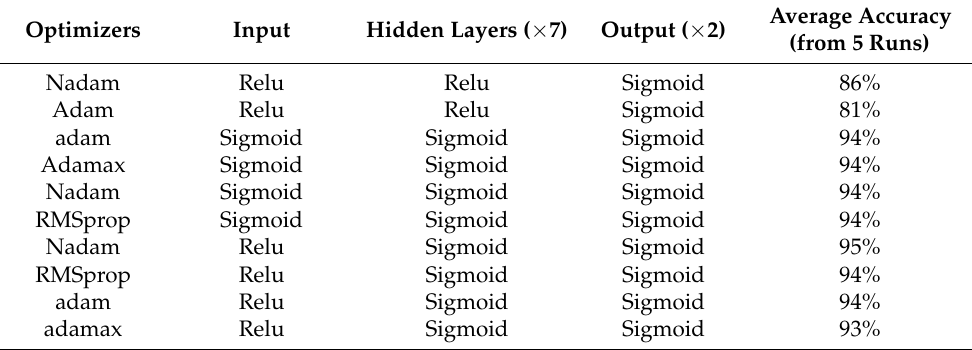
Table 5. Optimizers and activation functions.